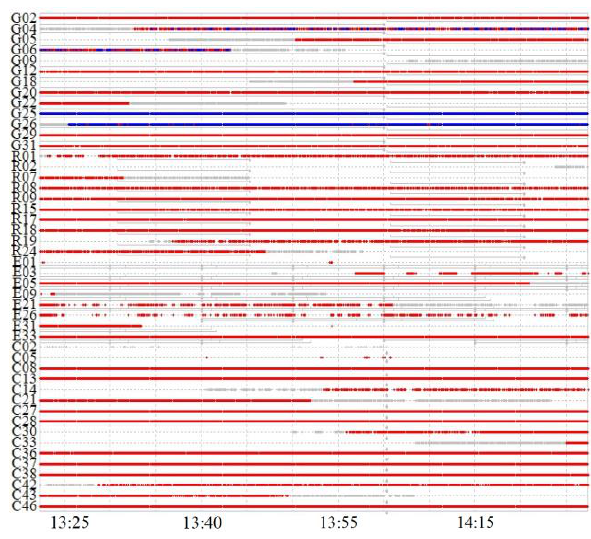
Figure 3 . The satellite visibility for one